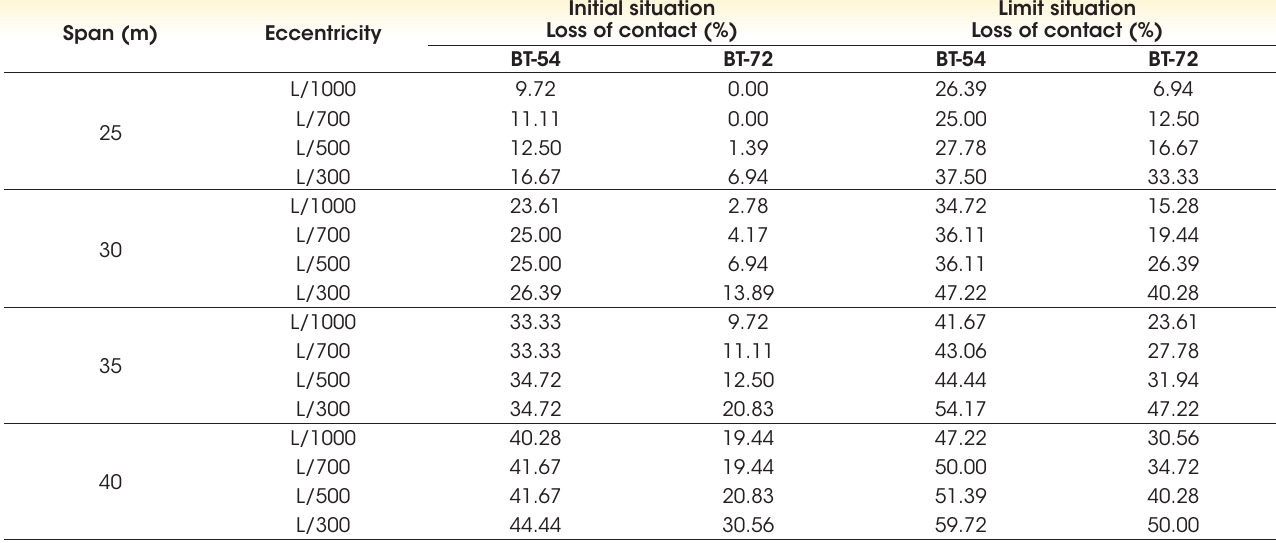
Loss of contact in the limit load situation of the beams under analysis